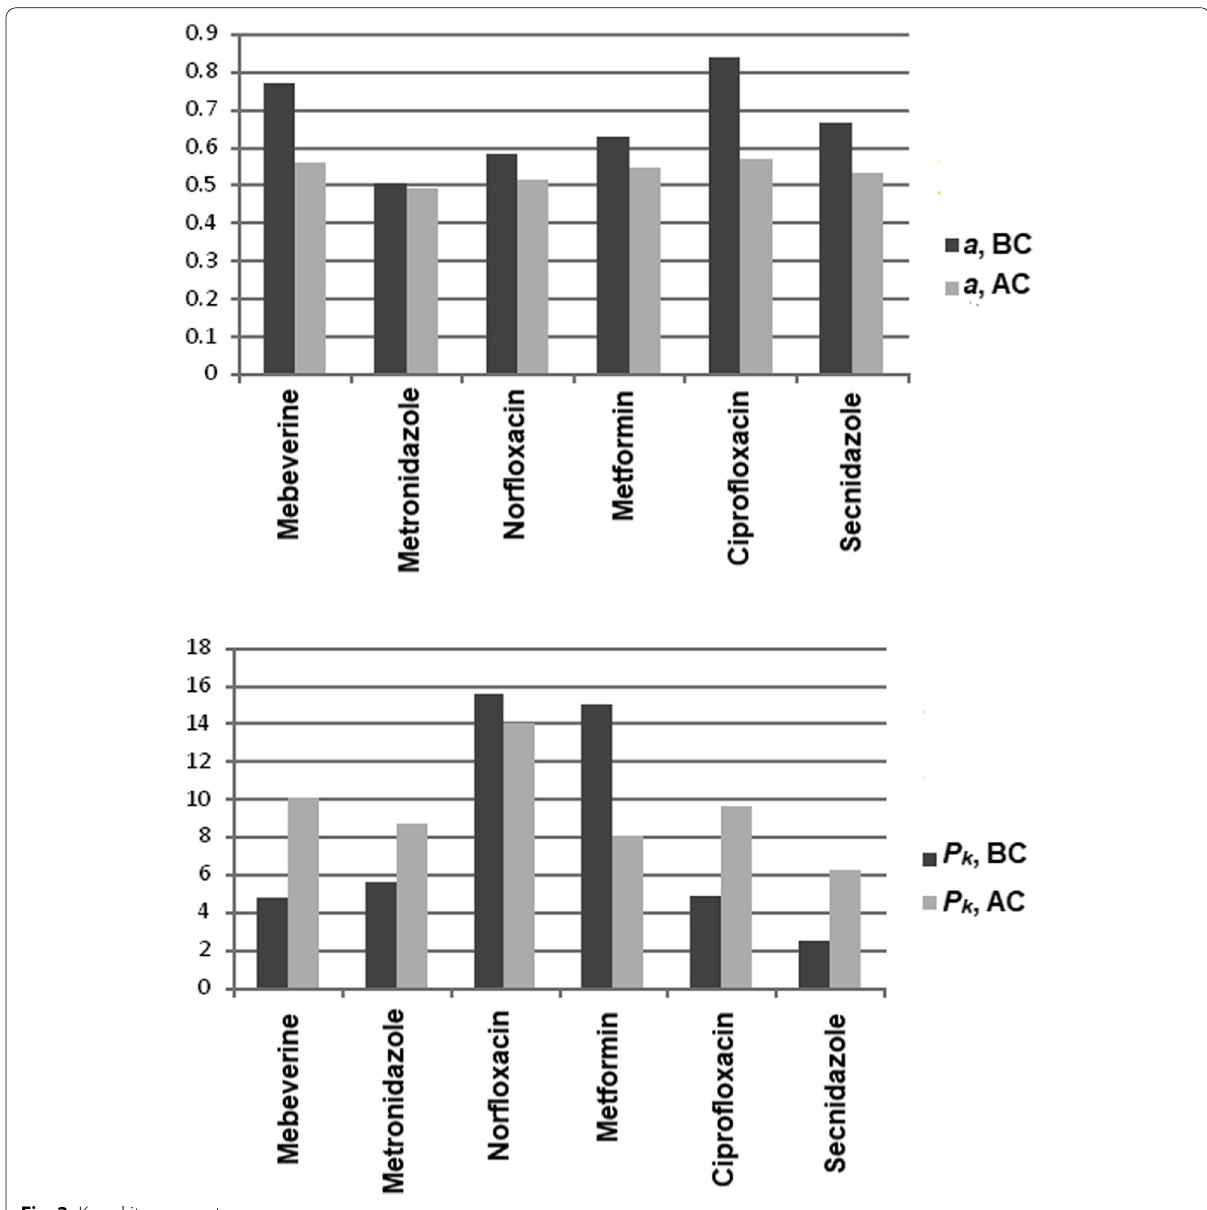
applied. Accordingly, the area under the rearranged Kawak- ita equation is the summation of the areas over the whole pressure range under which the powders were compressed using the GTP, i.e., from an initial compression pressure ( P i ) ematical representation of the aforementioned area is given in Eq. 3, the solution to this equation is presented in Eq.